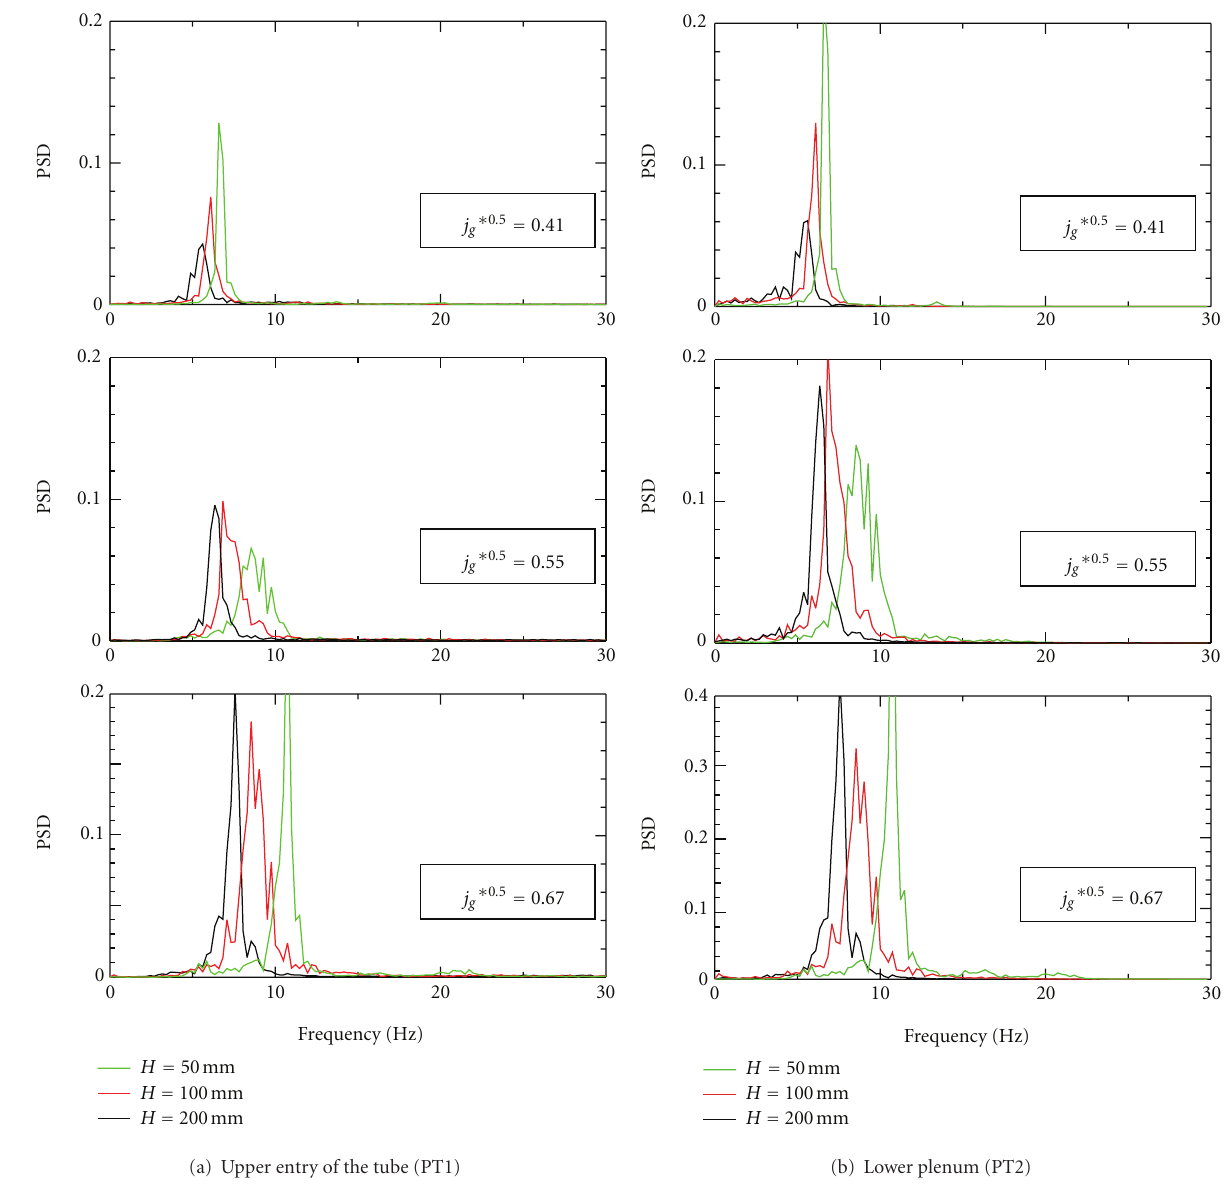
Figure 14: Power spectrum density (PSD) of pressure fluctuations for various air flow rates and water levels (tube diameter D = 20mm).